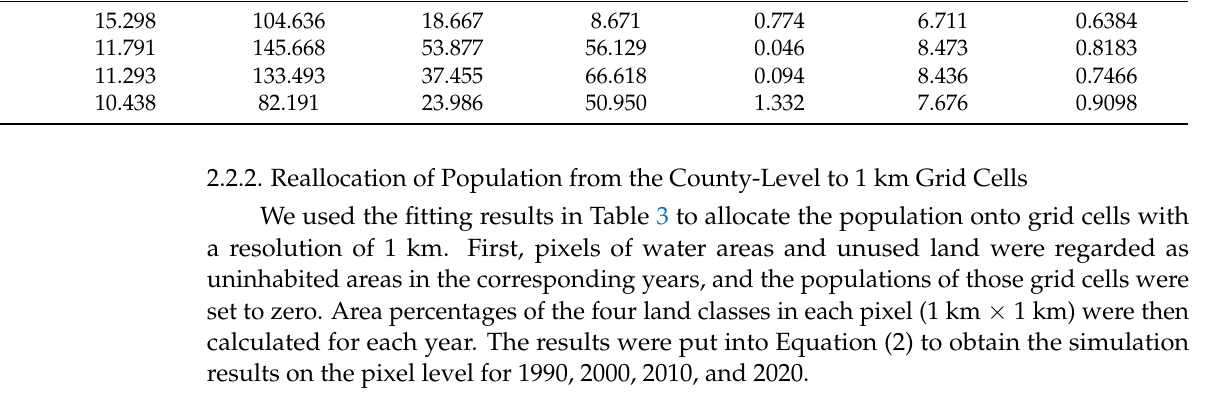
Table 3. Fi tt ing results of the weight and intercept terms for each year.